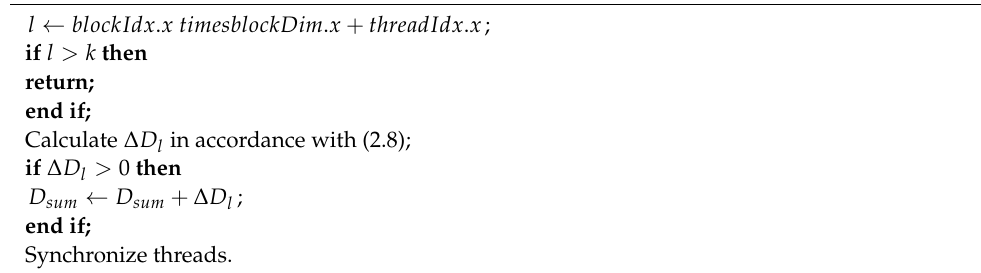
Algorithm 7 CUDA implementation of Step 3 in Algorithm 2